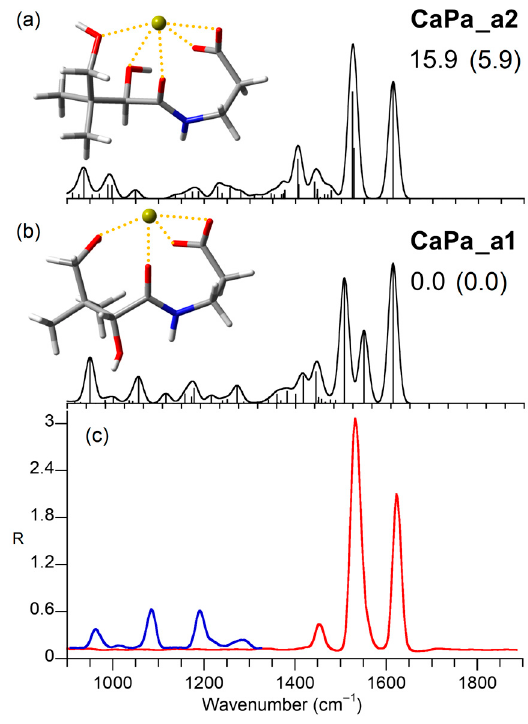
Figure 5. ( c ) IRMPD spectrum of [Ca(panto-H)] + in the fingerprint range obtained submitting the ions either to 1 second of FEL light (blue profile) or to 500 ms using one attenuator (red profile). The calculated spectra of the lowest lying structures ( b ) CaPa_a1 and ( a ) CaPa_a2 are reported in black together with their optimized geometry and relative free energies (298 K) at the B3LYP and MP2 (in bracket) levels in kJ mol − 1 . Table 1. Observed IRMPD bands and calculated vibrational frequencies for the lowest lying struc- tures CaPa_a1 and CaPa_a2 of [Ca(panto-H)] + .